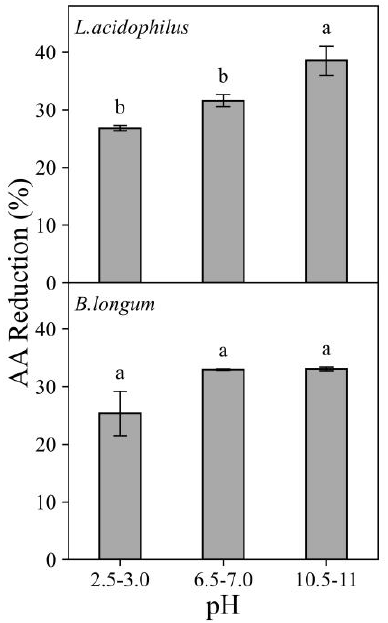
Figure 4. Effects of pH on the acrylamide (AA) reduction ability of L. acidophilus and B. longum at 10 9 CFU/mL when exposed to 750 ng/mL AA solutions at three different pH conditions (pH 2.5 – 3.0, 6.5 – 7.0 and 10.5 – 11.0). Incubated at 37 °C for 4 h. Expressed as AA reduction percentage. Different characters in each panel indicate significant differences, whereas same character indicate no significant difference.